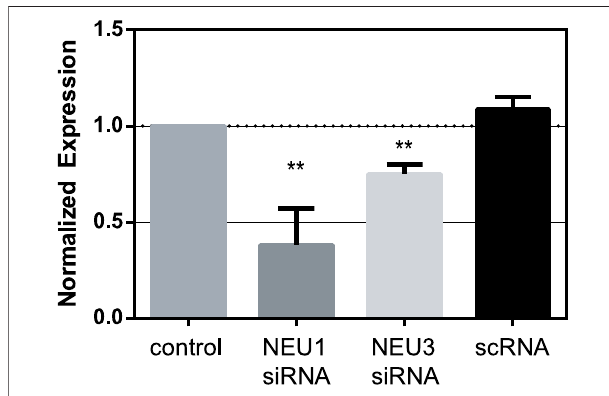
FIGURE 1 | Knockdown of NEU1 and NEU3 expression using siRNA. JurkatcellsweretransfectedwithsiRNAforNEU1,NEU3,orwithascrambled control(scRNA).Westernblotswereusedtodeterminechangesinexpression ofNEU1andNEU3(see SupportingInformation ).Blotswereanalyzed bydensitometry, andthe averagechangesinexpression areshown relative to controls. Values were compared to control using a Student ’ s t-test (** p < 0.01).